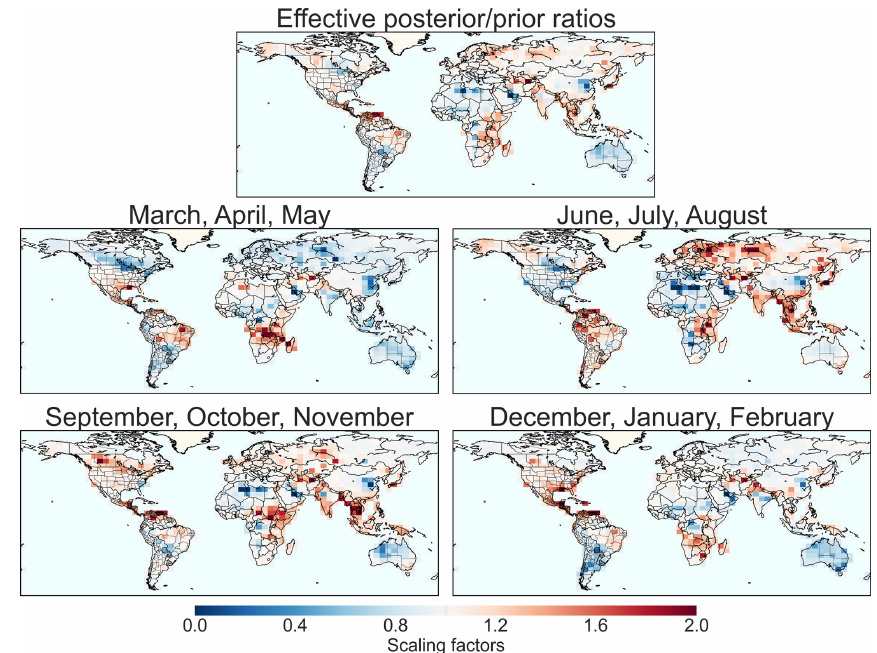
Figure B1. Results from the seasonal inversion, showing effective posterior/prior scaling factors in the top panel and the seasonal scaling factors in the four bottom